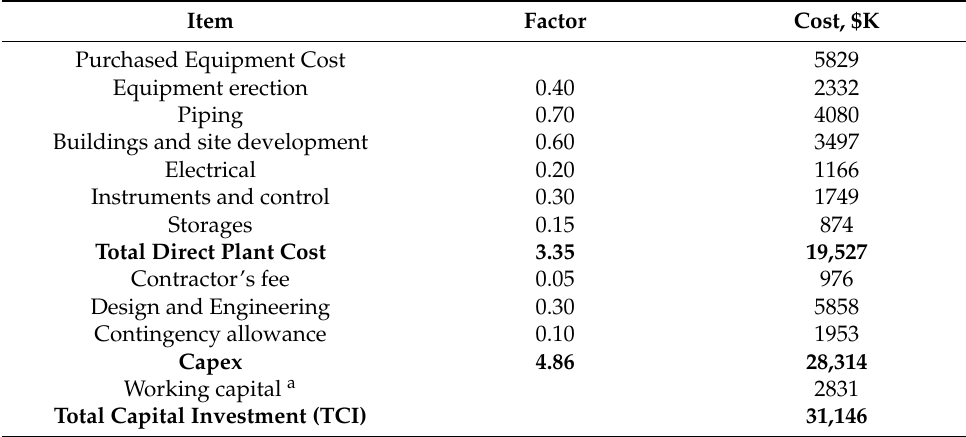
Table 7. Ratio factors for direct and indirect capital